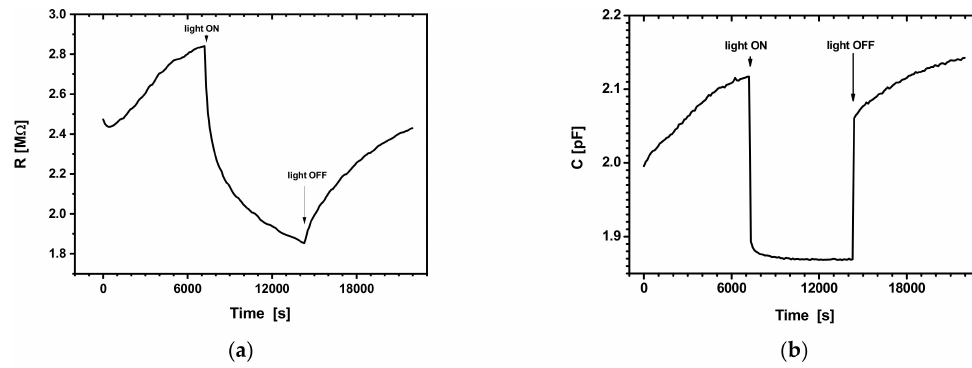
Figure 7. ( a ) R (t) at U DC = 10 V, with light off-on-off; ( b ) C (t) at U DC = 10 V, with light